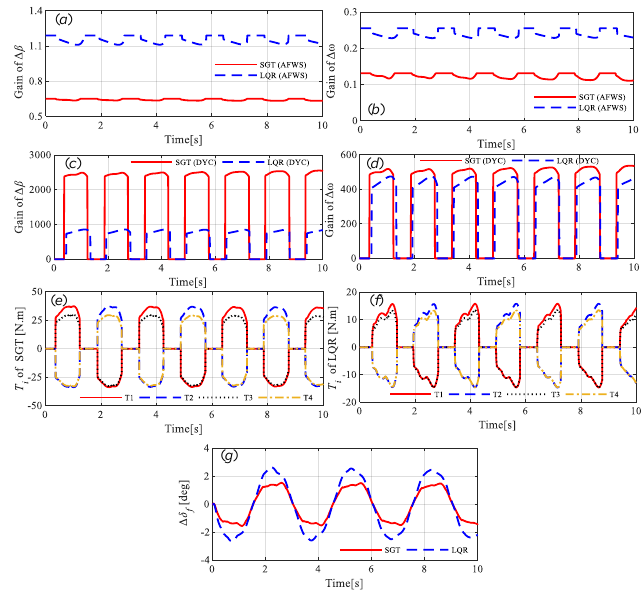
Figure 8. State gains and control inputs of open-loop sinusoidal steering test at 100 km / h. ( a ) Gain of Δ β (AFWS); ( b ) gain of Δω (AFWS); ( c ) gain of Δ β (DYC); ( d ) gain of Δω (DYC); ( e ) additional torque of SGT; ( f ) additional torque of LQR; ( g ) additional front wheel steering angle.